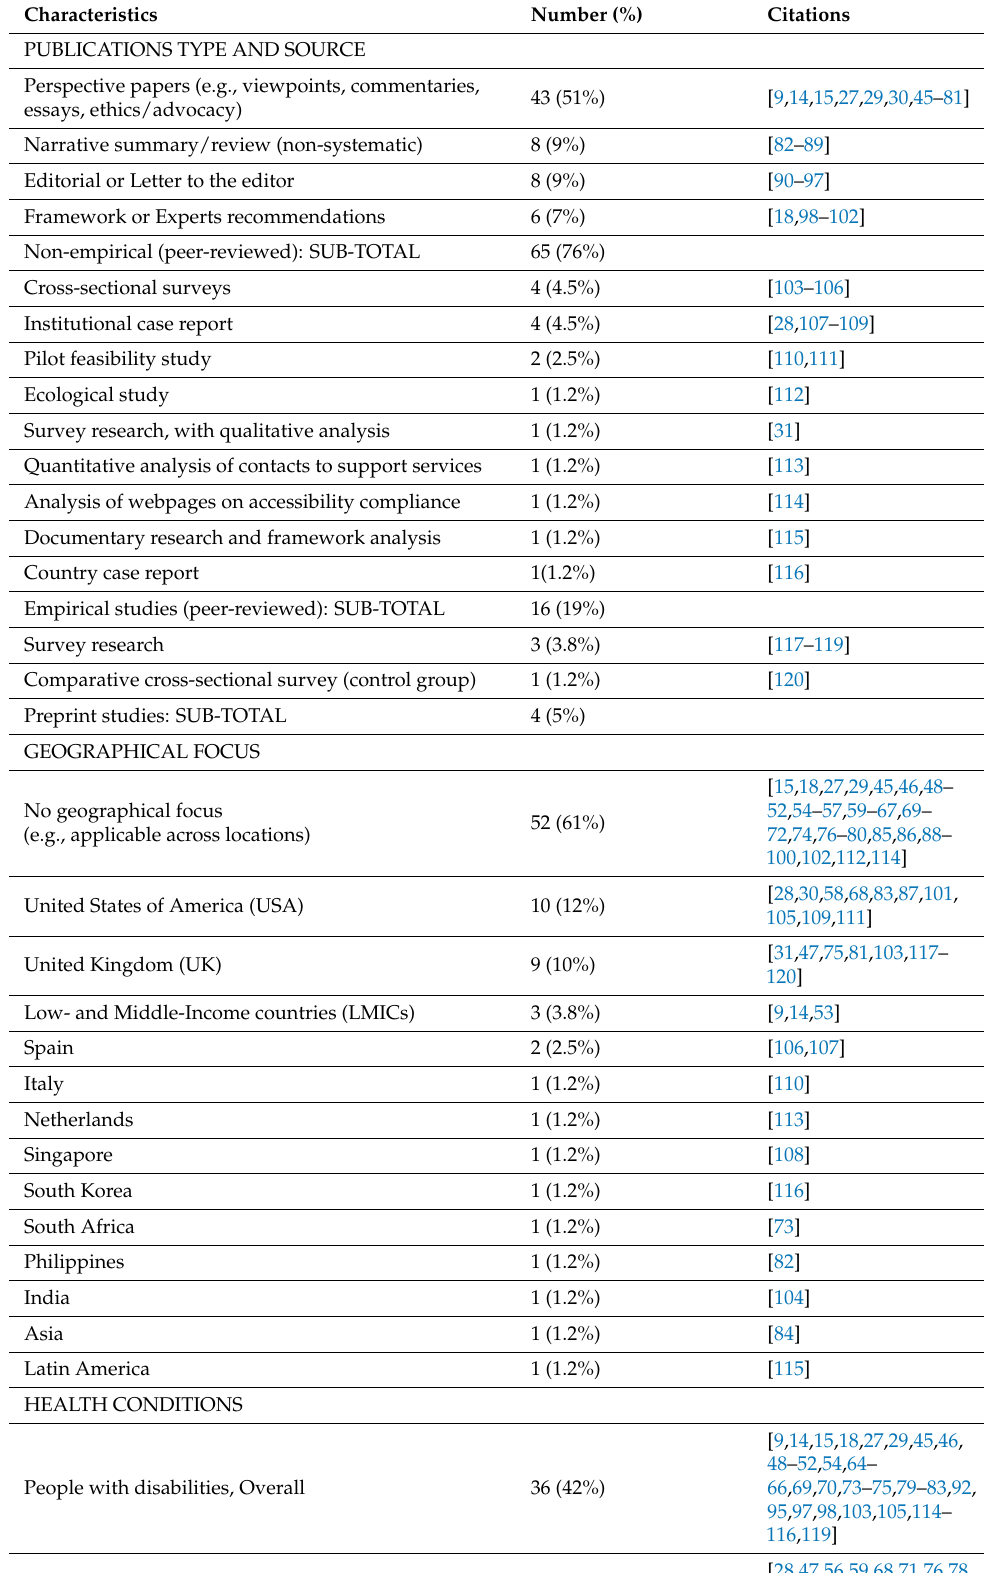
Table 1. Quantitative map of the literature